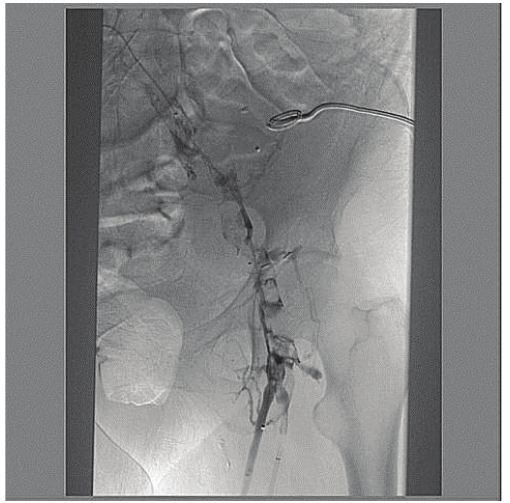
Figure 3: Intravascular ultrasound (IVUS) in the left iliac vein (anterior at top of image) demonstrating compression from the adjacent right iliac artery (2 o’clock position) before stenting.